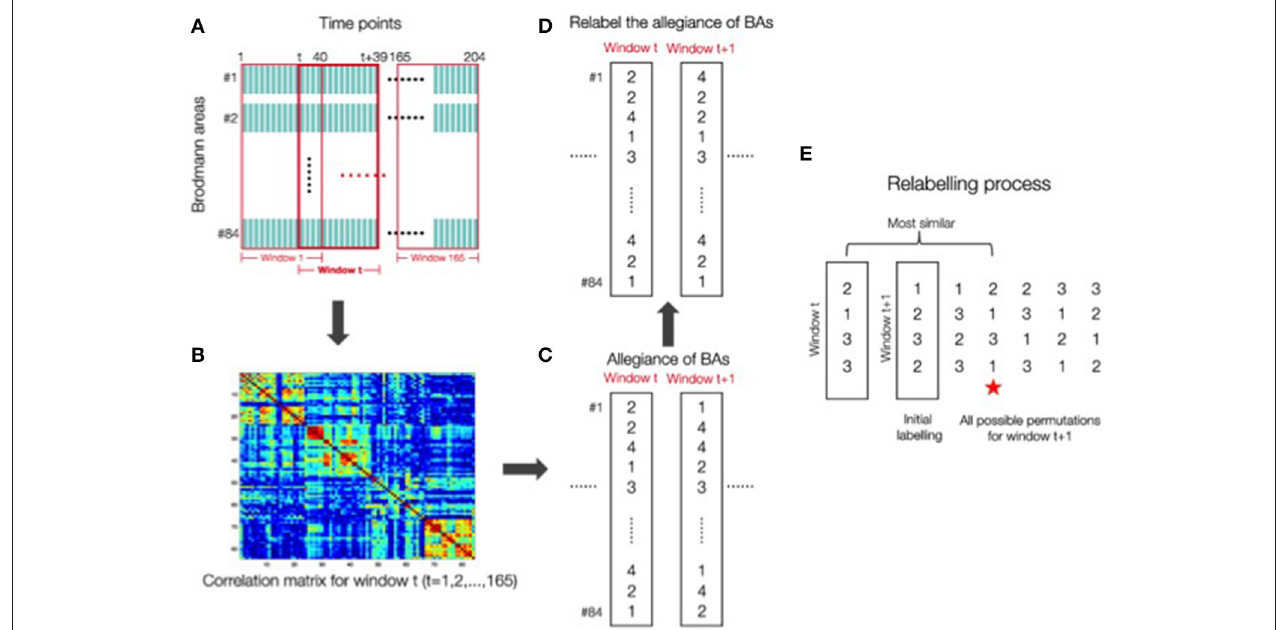
FIGURE 1 | (A) Flexibility calculation using a sliding window method with 40 time points. (B) For each window a correlation matrix was obtained. (C) Computation of the record of which module the i th Brodmann areas was in C1( t ) at time point window t , 1 ≤ t ≤ 165. (D) Relabeling of the allegiance of Brodmann areas was done to account for the fact that the labeling of the modules can change between time points. This relabeling process was done to ensure that the difference defined as the number of areas that have Ci( t + 1) 6= Ci( t ) ( i = 1–84) was minimized. (E) A detail of the relabeling process is shown here. The red star indicates that the permutation for window ( t + 1) “2 1 3 1” is the closest to the window t labeling “2 1 3 3”. The relabelling process will choose the starred permutation for window ( t